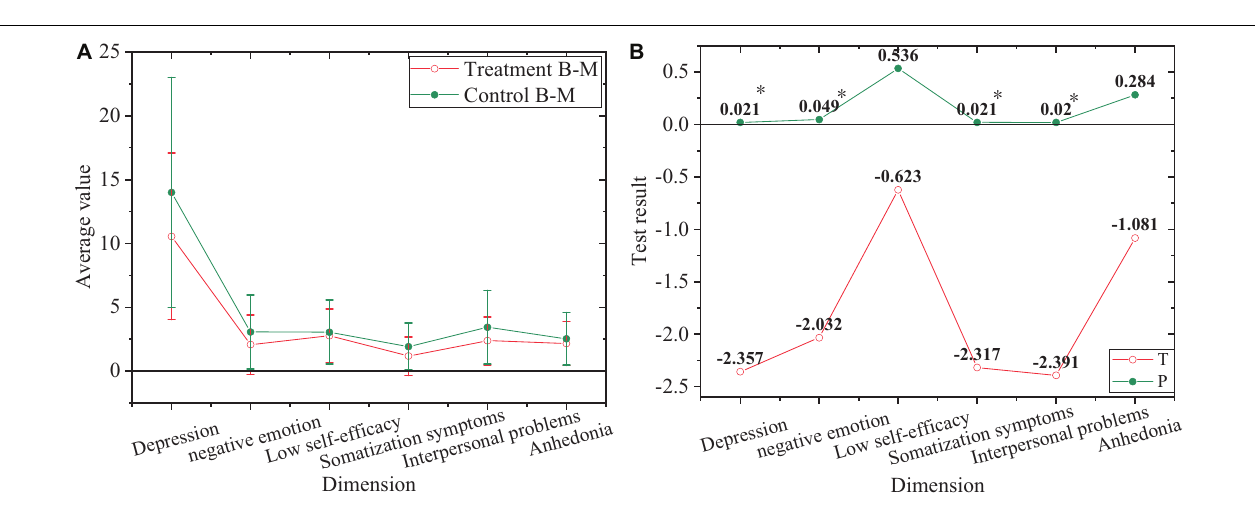
FIGURE 12 | Comparison of negative emotions. (A) Values of male subjects after the experiment. (B) Value of T and P of male subjects after the experiment. “ ∗ ”Shows a significant difference, while “ ∗∗ ” means a highly significant